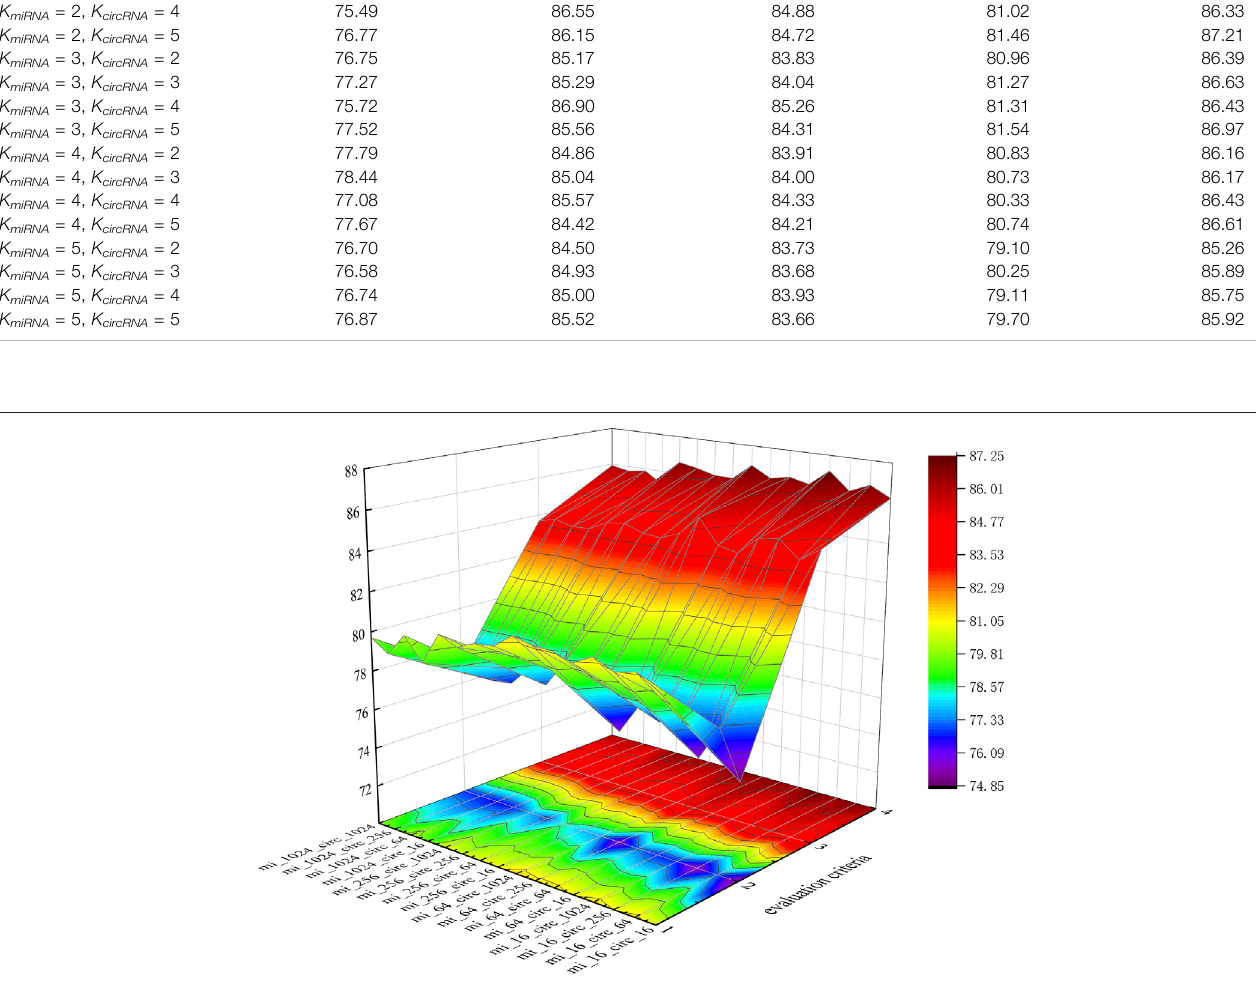
FIGURE 6 | Performances of different K